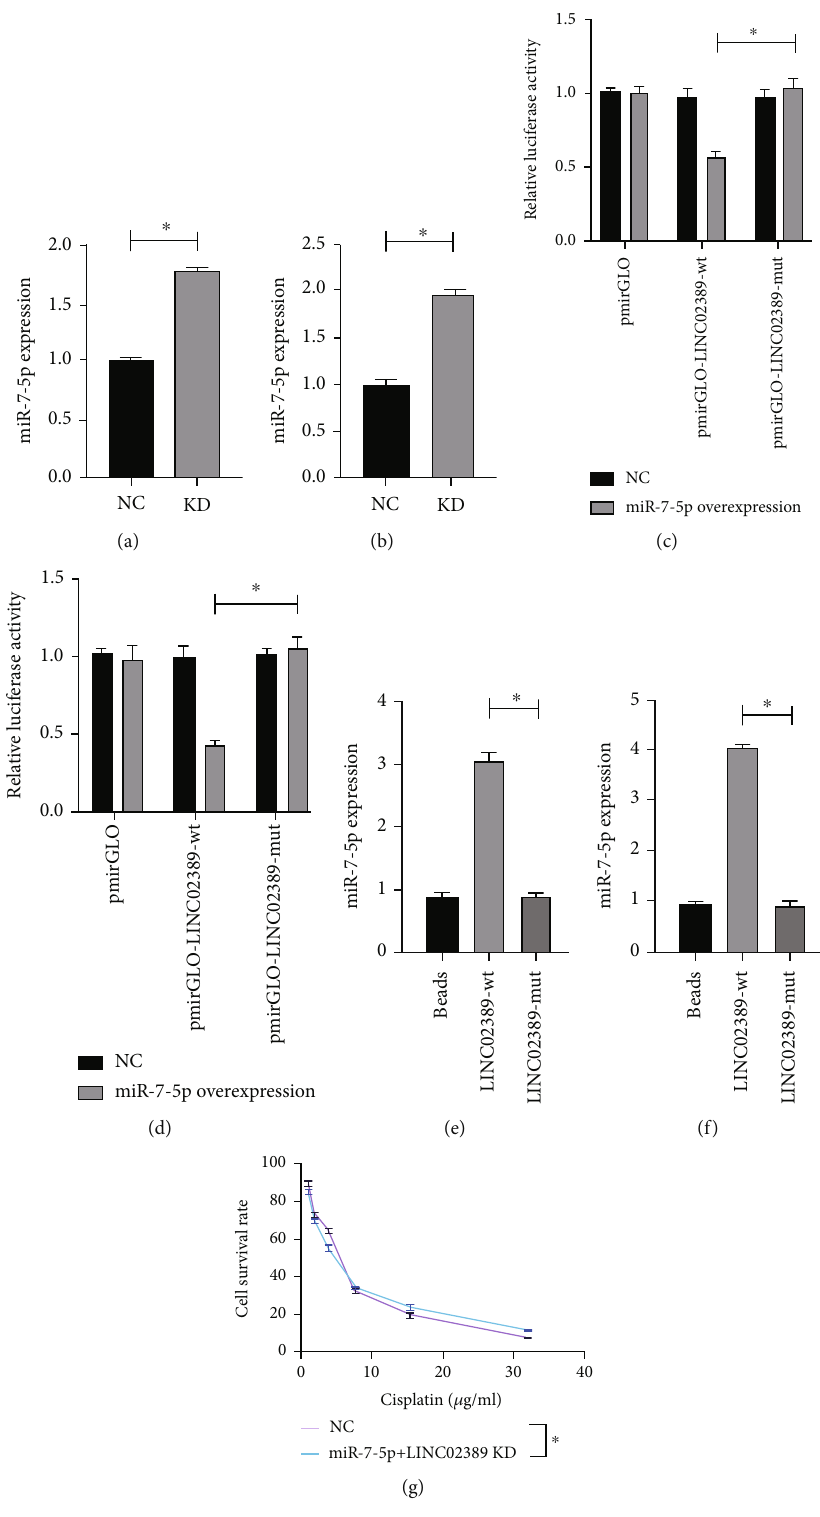
Figure 5: (a) miR-7-5p expression in LINC02389 knocked down A549 cell line. (b) miR-7-5p expression in LINC02389 knocked down HCC827 cell line. (c) Dual luciferase activity assay to test the binding of LINC02389 to miR-7-5p in A549. (d) Dual luciferase activity assay to test the binding of LINC02389 to miR-7-5p in HCC827. (e) RNA pull-down assay to test the interaction between miR-7-5p and LINC02389 in A549. (f) RNA pull-down assay to test the interaction between miR-7-5p and LINC02389 in HCC827. (g) miR-7-5p knockdown could reverse the e ff ect of LINC02389 knockdown on IC50 of A549-R to